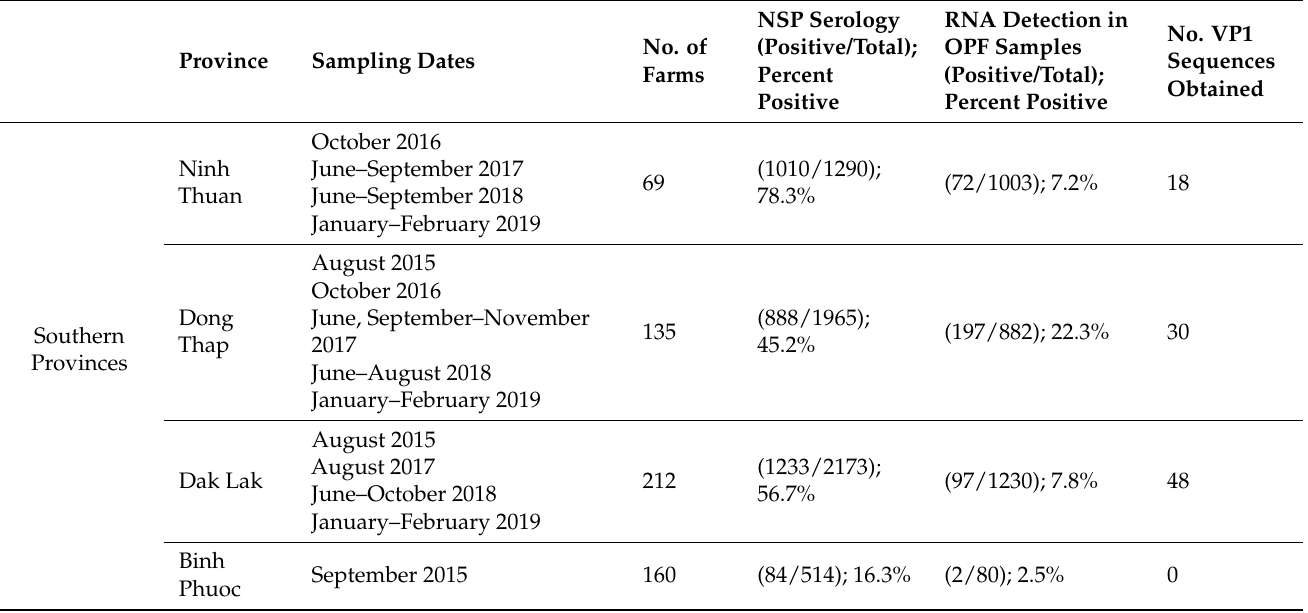
Table 1. Descriptive characterization of longitudinal farm sample screening for FMDV NSP-serology, detection of FMDV RNA in oropharyngeal fluid (OPF), and sequence